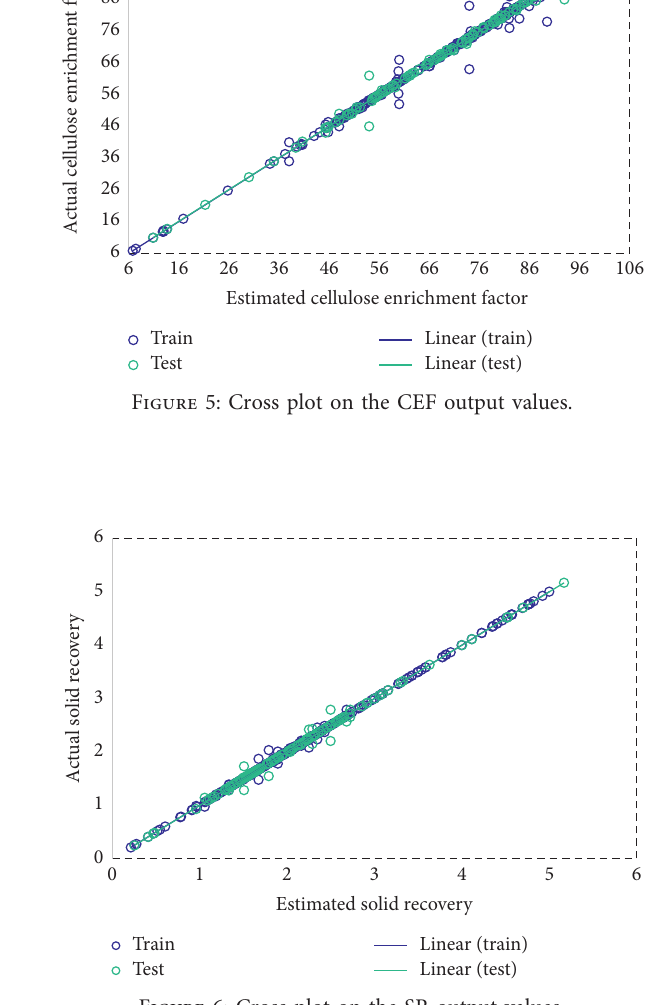
Figure 6: Cross plot on the SR output